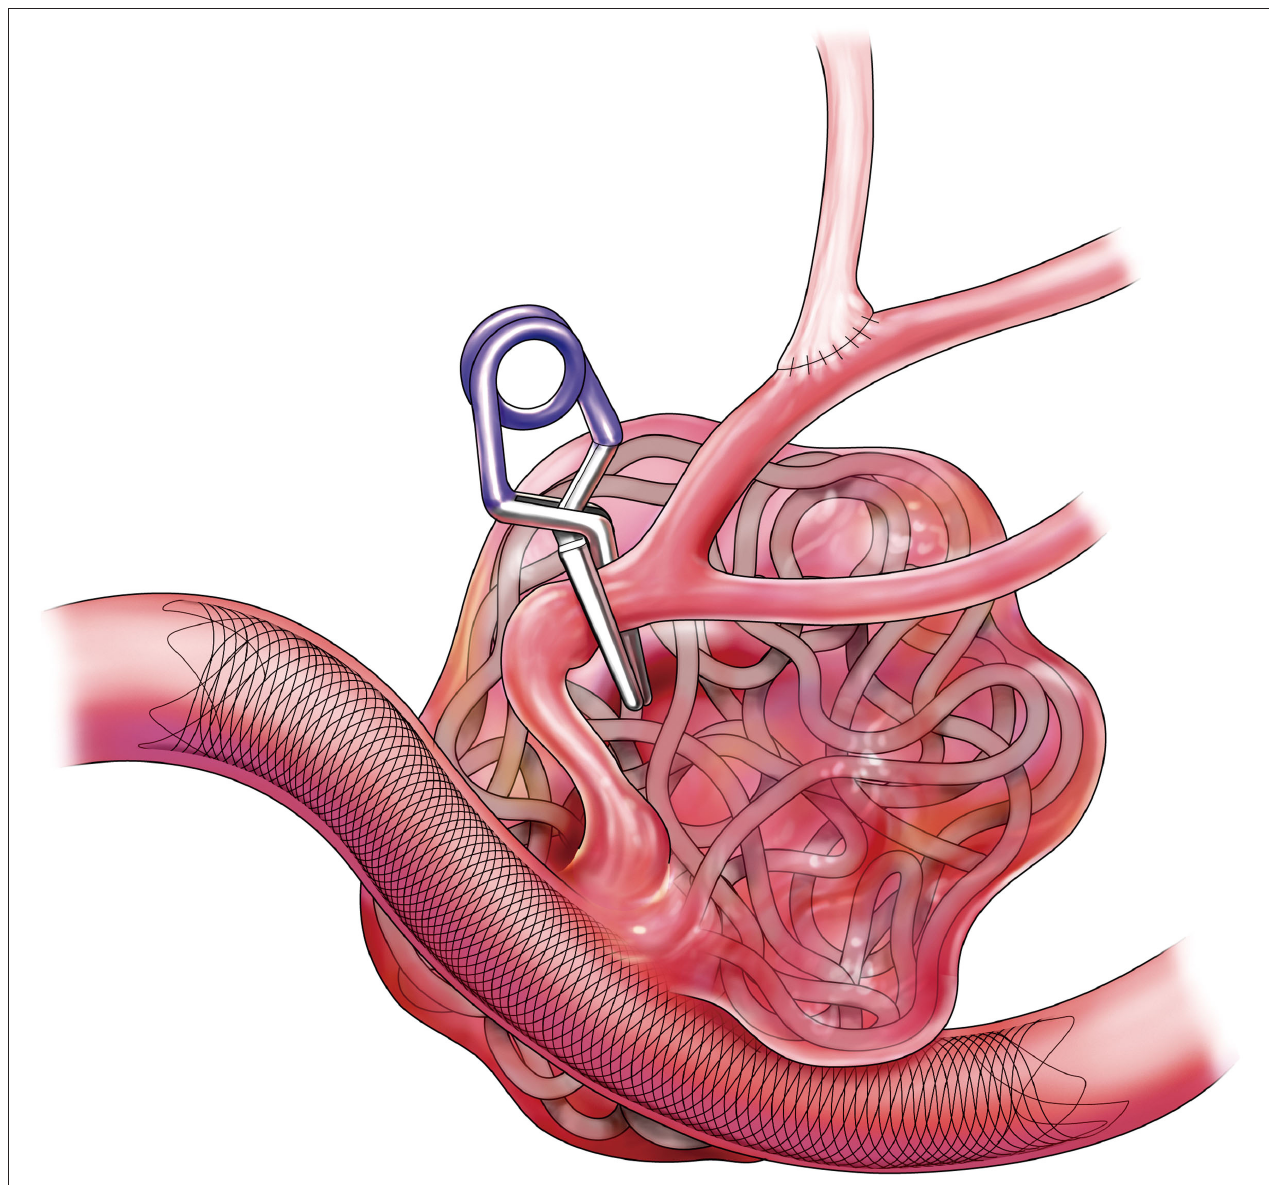
FIGURE 6 | Schematic illustration depicting the present techniques.